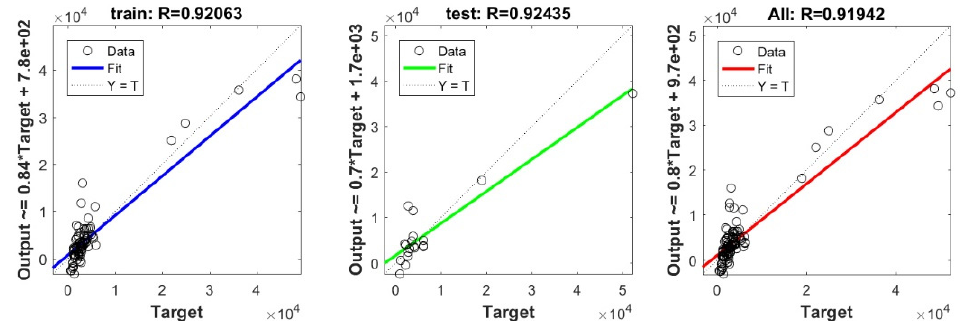
Figure A5. Scatter plots between target and output values by the KRidge model.